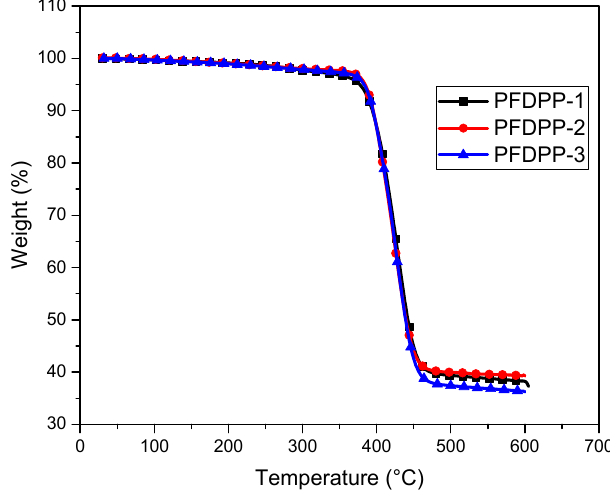
Figure 3. TGA thermograms of the PFDPP polymers.